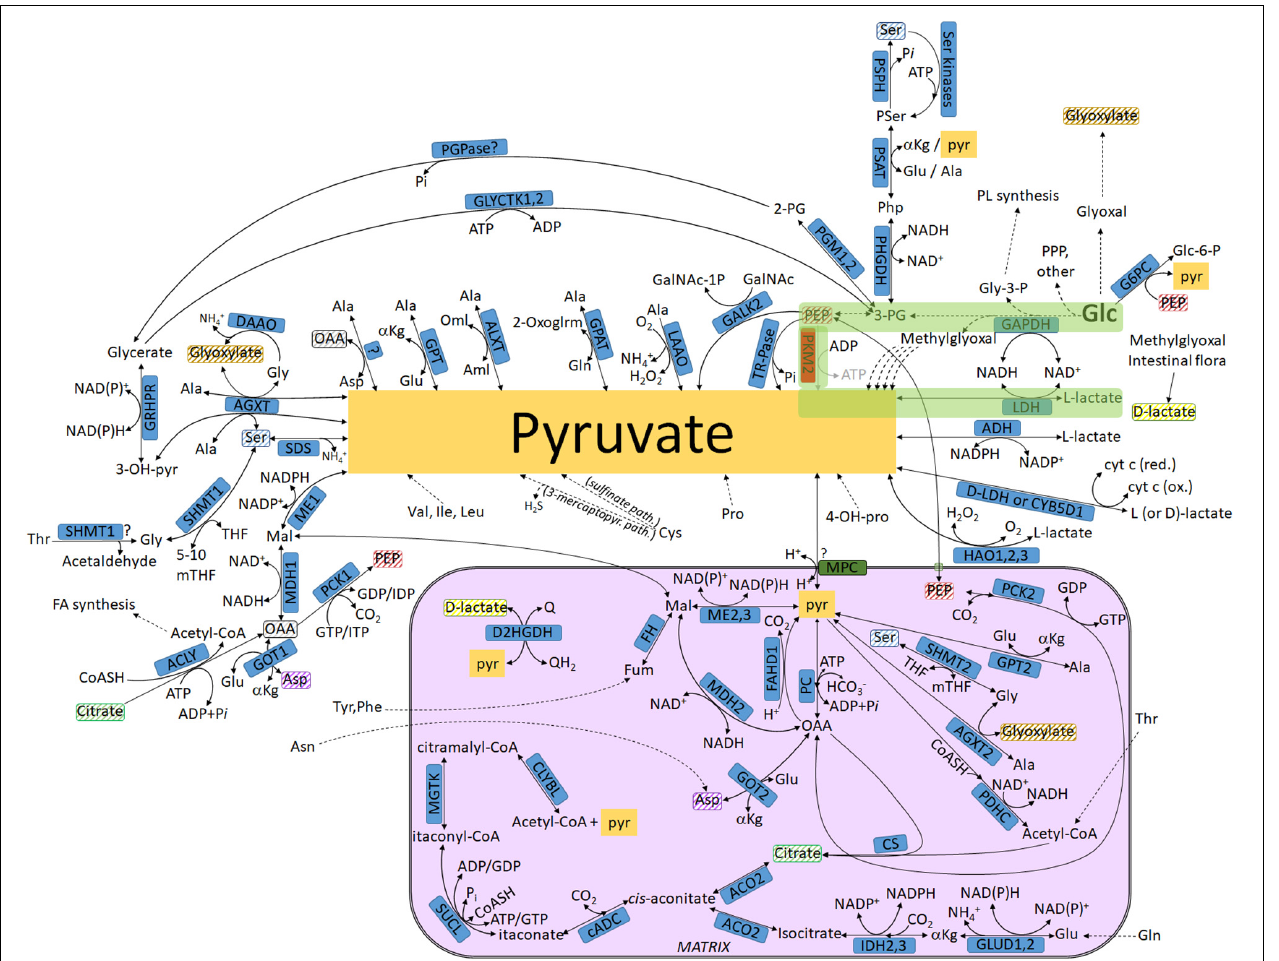
FIGURE 1 | Biochemical pathways connecting glucose or other metabolites to pyruvate and L- or D-lactate. The box in magenta represents a mitochondrion. Glycolysis is highlighted in green. Metabolites found both inside and outside the mitochondria that are not connected with an arrow are highlighted in matching striped colors (to avoid arrow clutter). For abbreviations, see Table 1